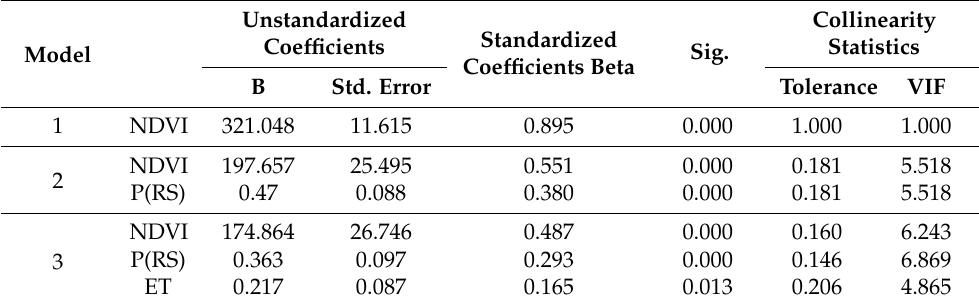
Table 2. Coefficient of four factors in stepwise regression.